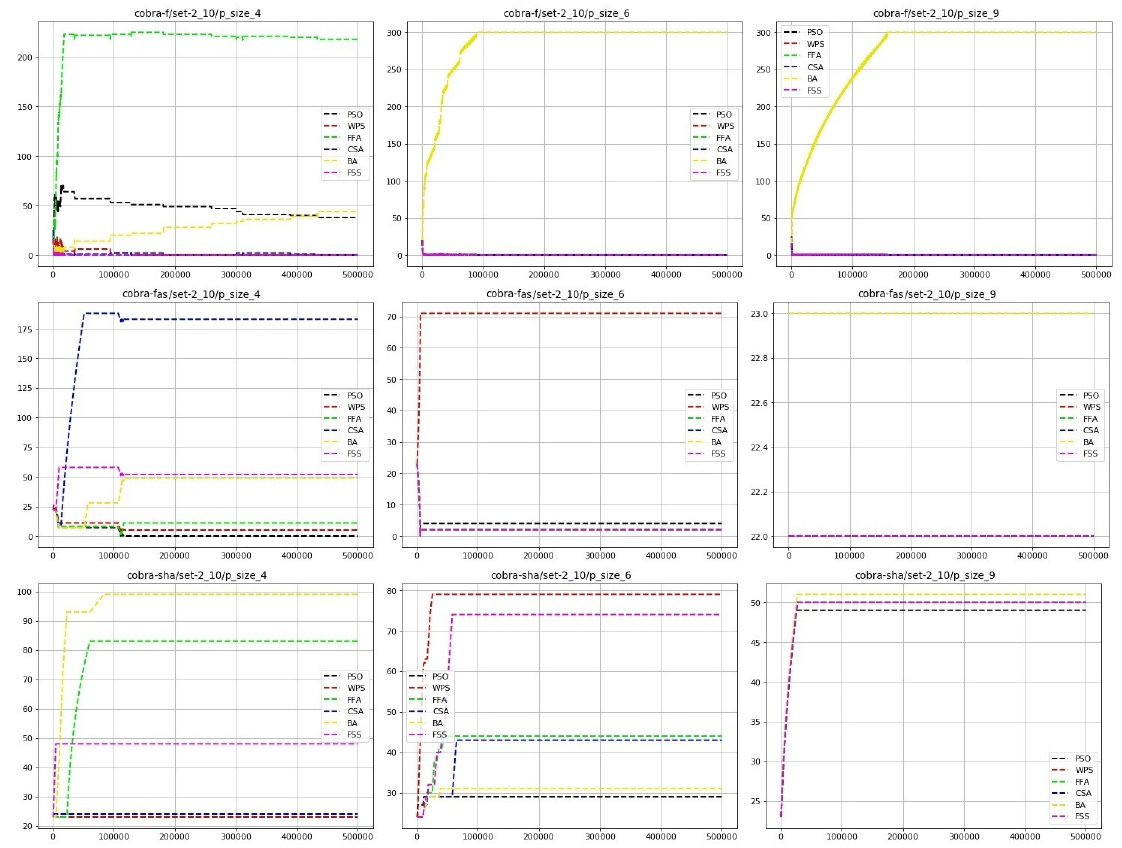
Figure 10. Population size changes for SET-2 with 10